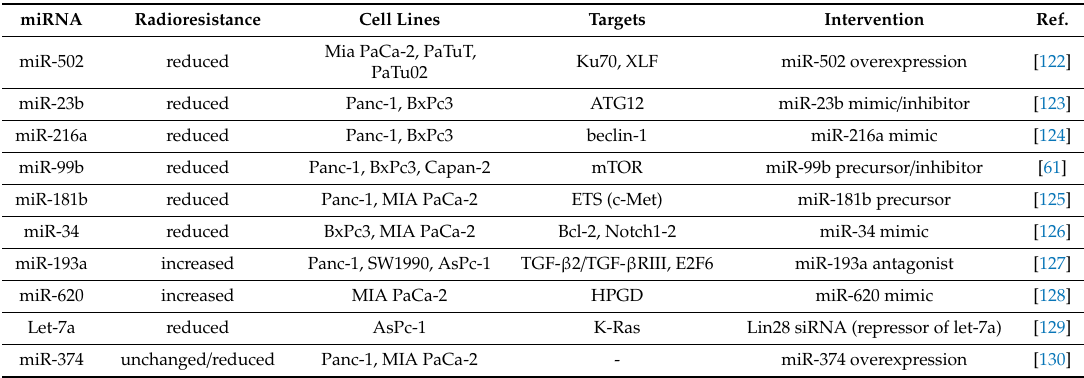
Table 3. miRNAs associated with radioresistance in pancreatic cancer. miRNAs, their e ff ect on radioresistance(reducedorincreased), theusedcelllines, theidentifiedtargetgenes, andtheintervention are